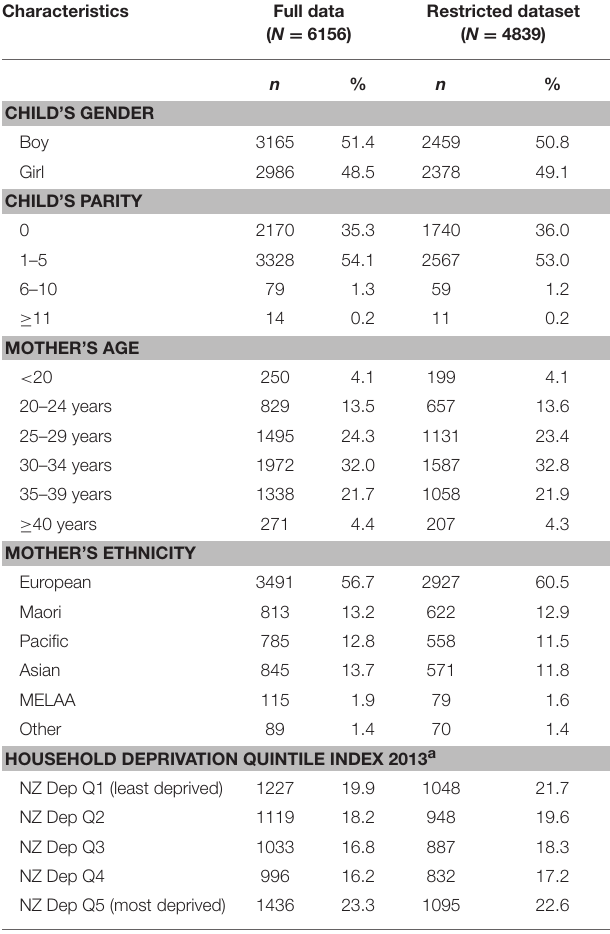
Socio-emotional competence at each DCW were further added together using two weighting methods to give overall